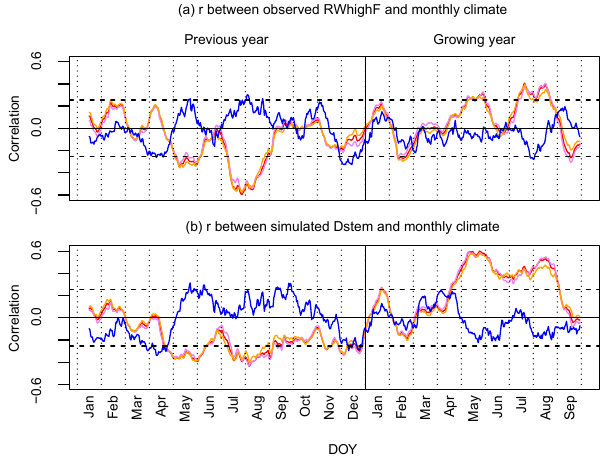
Figure 4. Correlation between monthly climate variables of the study area (precipitation in blue and mean, maximum and minimum temperature in red, violet and orange, respectively) and the mean of the detrended series of black spruce ring growth (RWhighF; a ) and the simulated detrended annual carbon allocation to the stem (Dstem; b ). For the climate variables, time windows of 31 days are used to obtain time series of monthly data (over the 1950– 2010 period) for each day (central day), averaging the values of each window and each year. These climate time series are then de- trended. Thresholds of significance ( p < 0 . 05) are shown by hori- zontal dashed